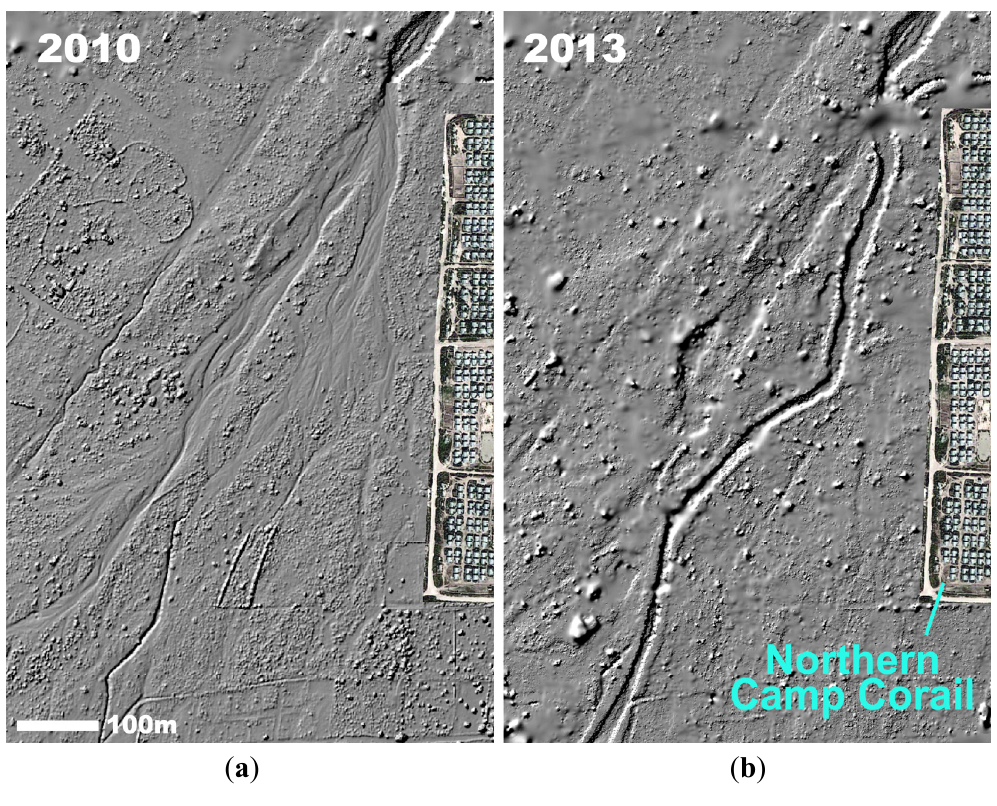
Figure 4. Comparison of the Ravine Lan Couline in the area of northern Camp Corail (Sector 3) before and after channel constructions based on the LIDAR DEM ( a ) and the Drone DEM ( b